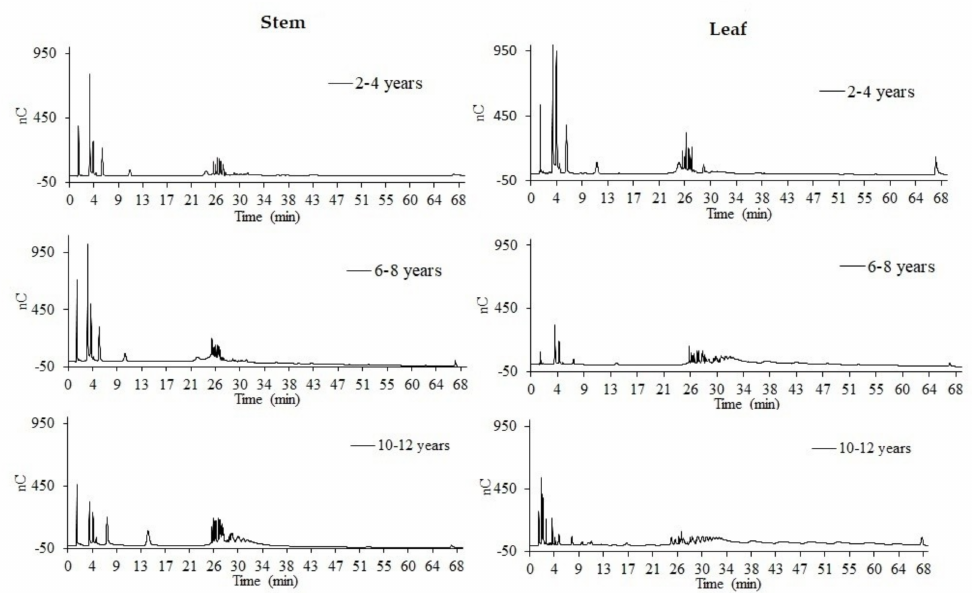
Figure 4. Agave fructan DP a dispersion in agave stem and leaf base in di ff erent ages of A. tequilana cenizo